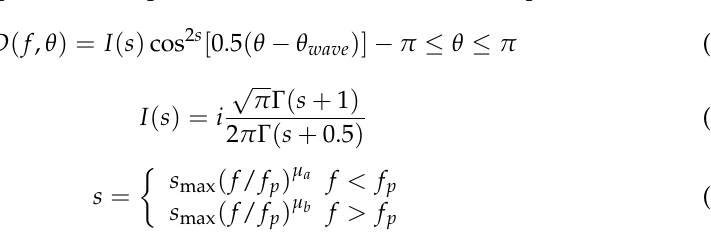
Figure 2. Comparison of hybrid sea spectrum with measured data. ( a ) Dominated by swells. ( b ) Dominated by wind waves.